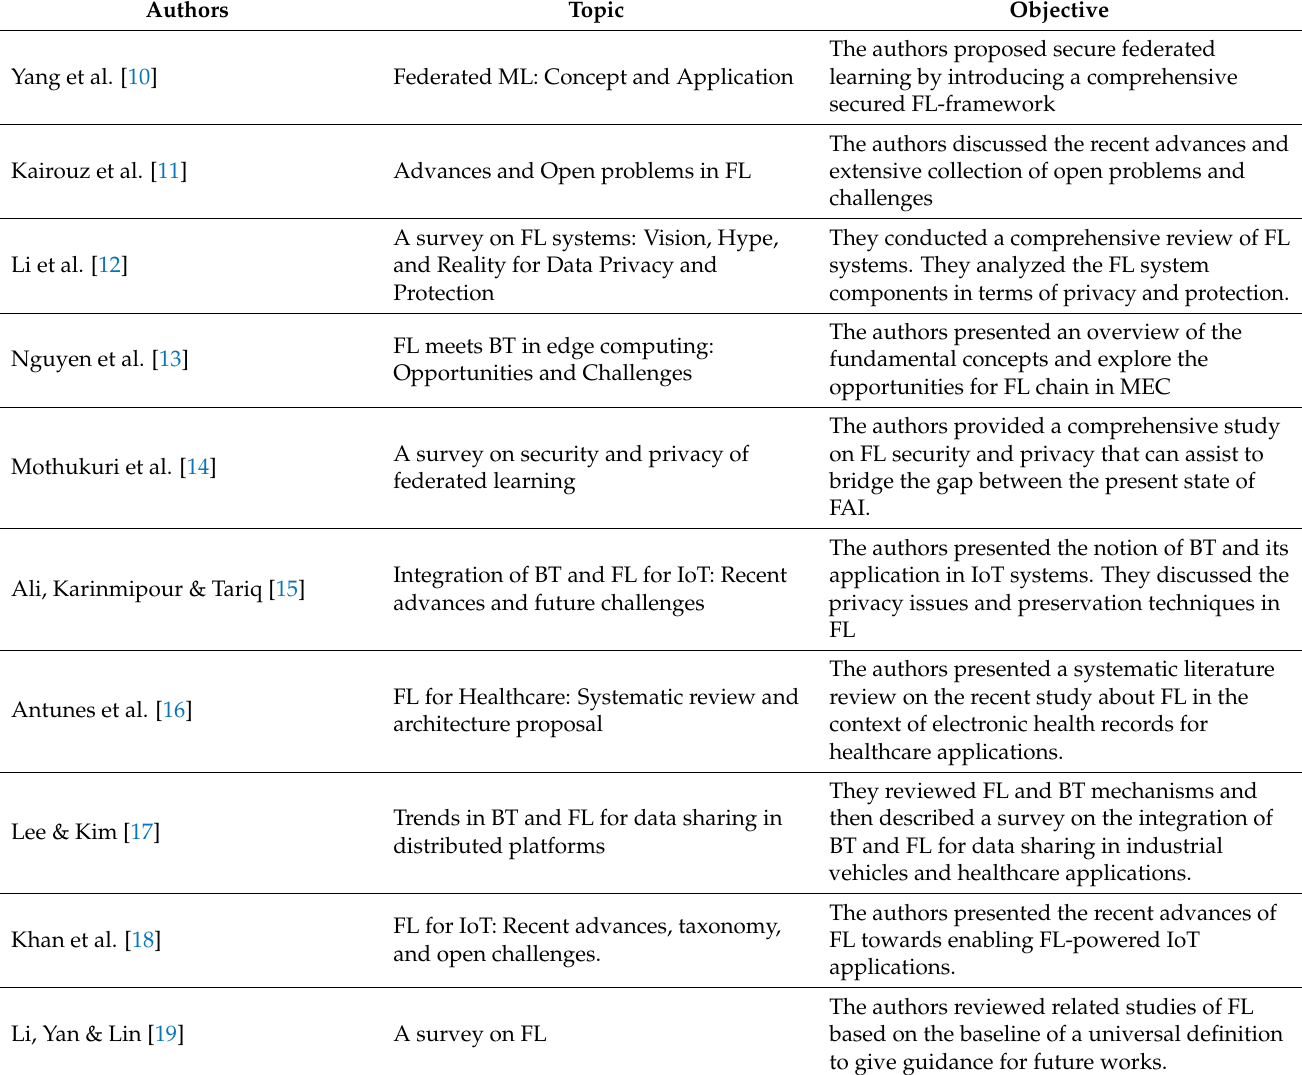
Table 1. Summary of the state-of-the-art related works